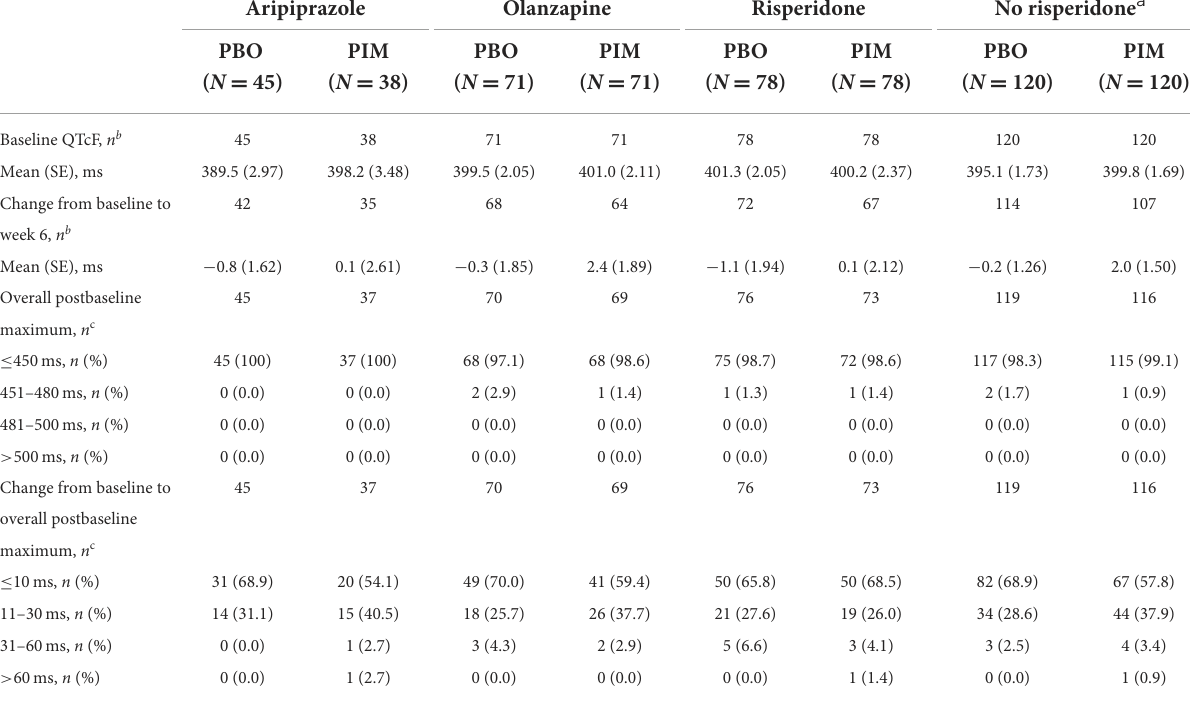
TABLE 2 ENHANCE: QTcF at baseline and on-study.